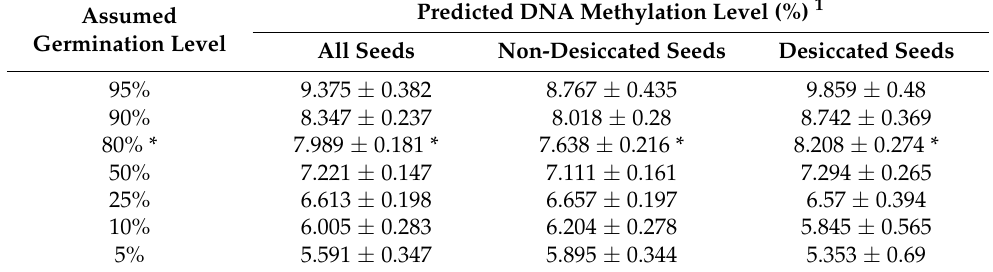
Table 2. Critical levels of germination and corresponding 5mC levels calculated according to a p.dose function constructed on GLM models on combined data from all seeds, and separate data from non-desiccated seeds at MC 12.5–14.5% and desiccated seeds at MC 7.6–7.8%.